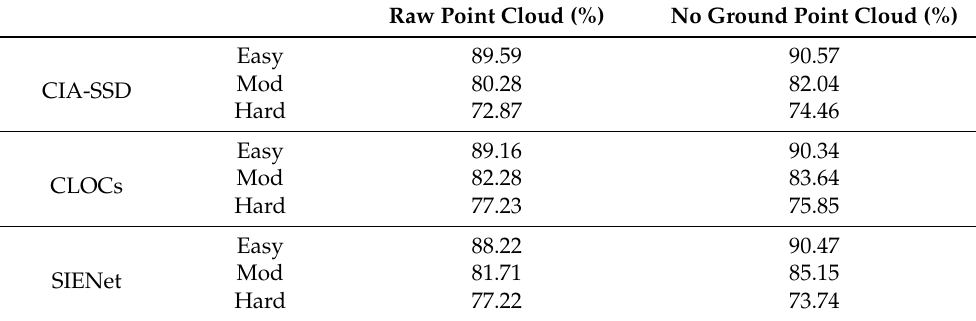
Table 3. Comparison of accuracy before and after ground filtering.